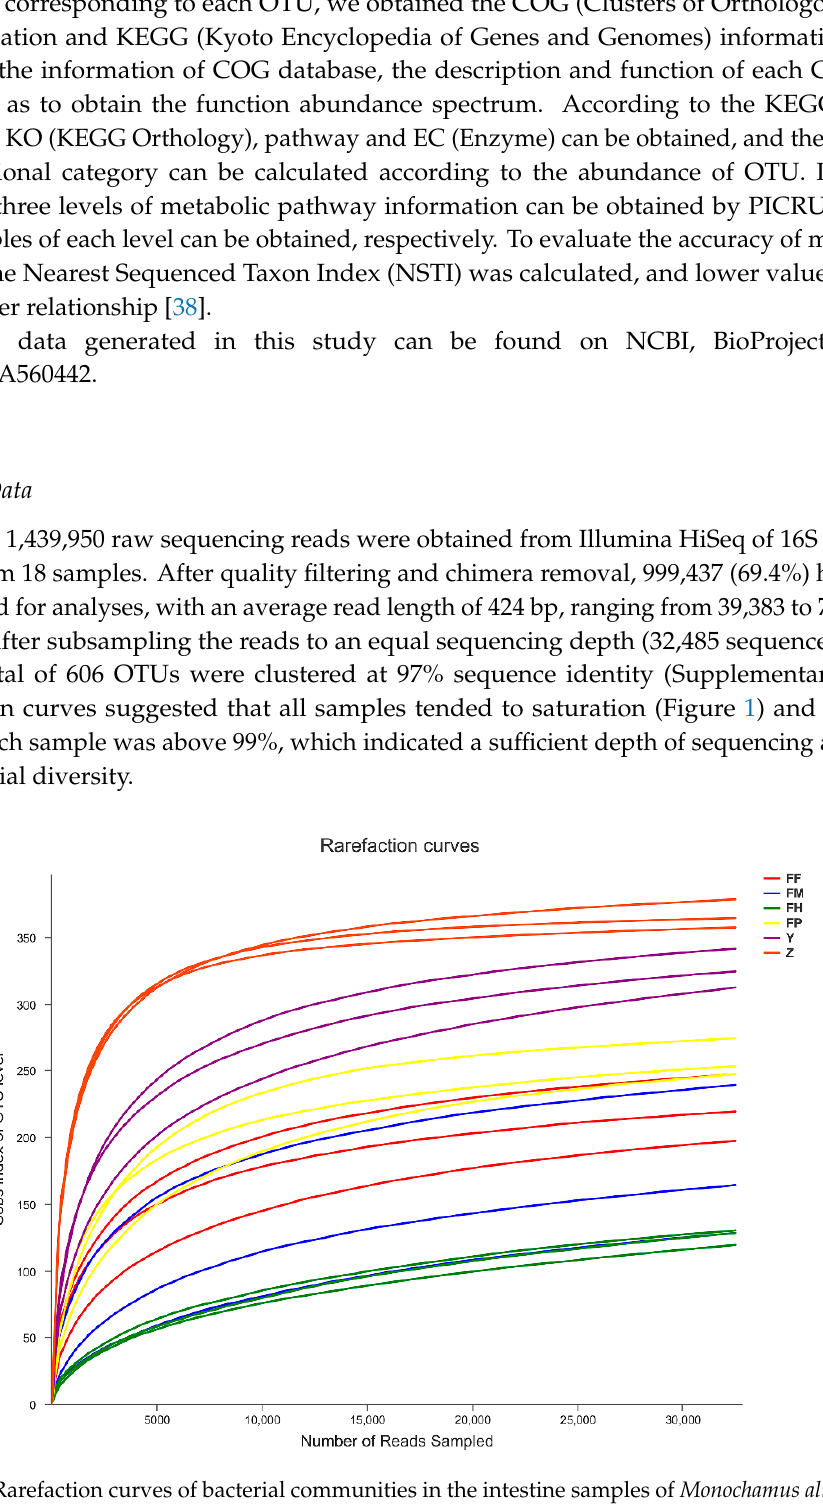
Figure 1. Rarefaction curves of bacterial communities in the intestine samples of Monochamus alternatus and tissue samples of Pinus massoniana . Sobs: number of species observed in the sample; FF: larval foreguts; FM: larval midguts; FH: larval hindguts; FP: pupal guts; Y: pupal chamber tissues; and Z: larval gallery tissues. All of these abbreviations apply to the following figures.